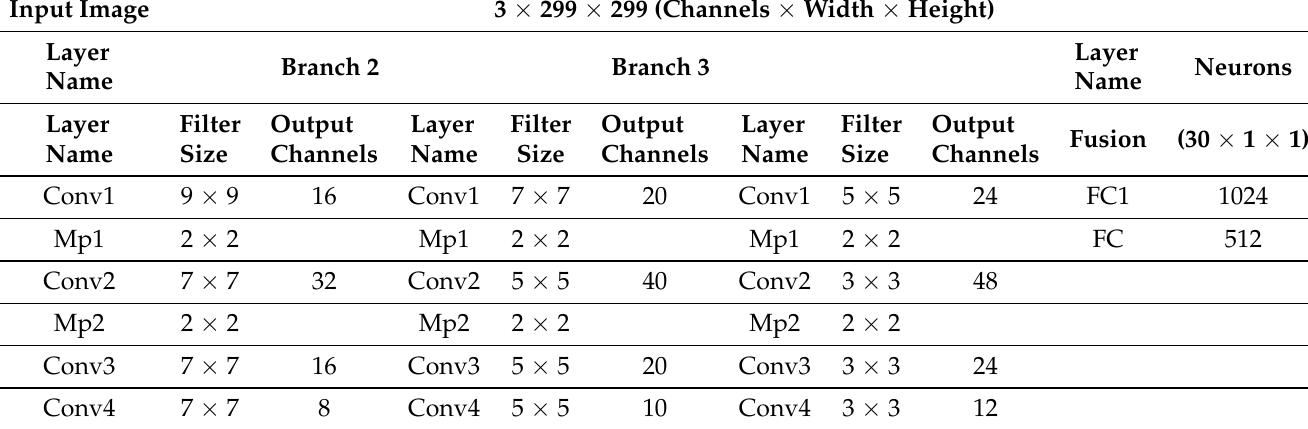
Table 3. Multicolumn network parameter